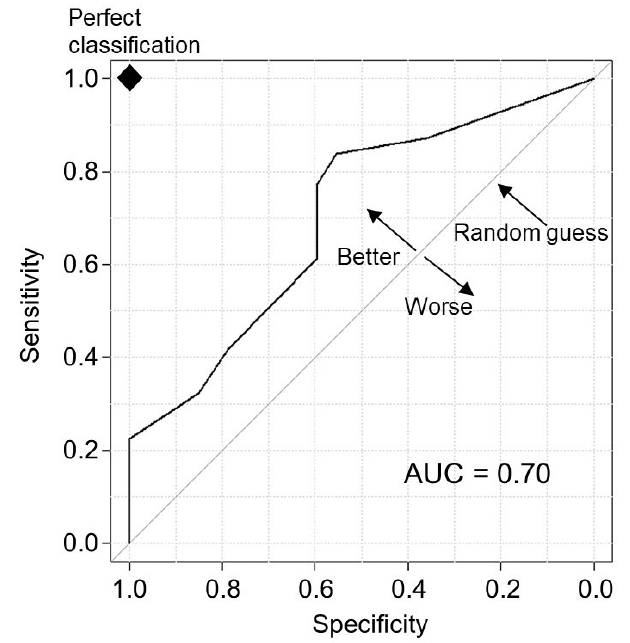
Figure 8. Receiver operating characteristic (ROC) curve for disease development prediction of onion downy mildew from 2016 to 2018 in Saga Prefecture, Japan.